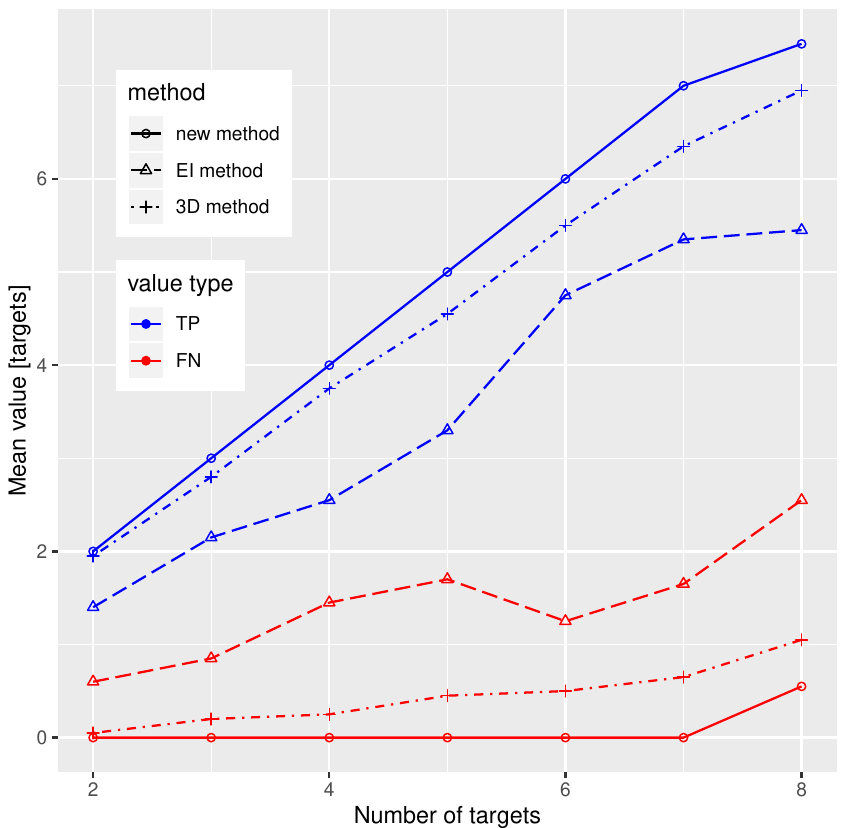
Figure 5. Performance comparison between the three methods. Two quantities, the number of true- positive (TP) resolved targets (blue) and false-negative (FN) unresolved targets (red) are visualised. Solid line together with circular points are used for the new algorithm, dashed line with triangular points for the ellipse intersection (EI) method and dash-dotted line with cross points for the three- dimensional (3D)